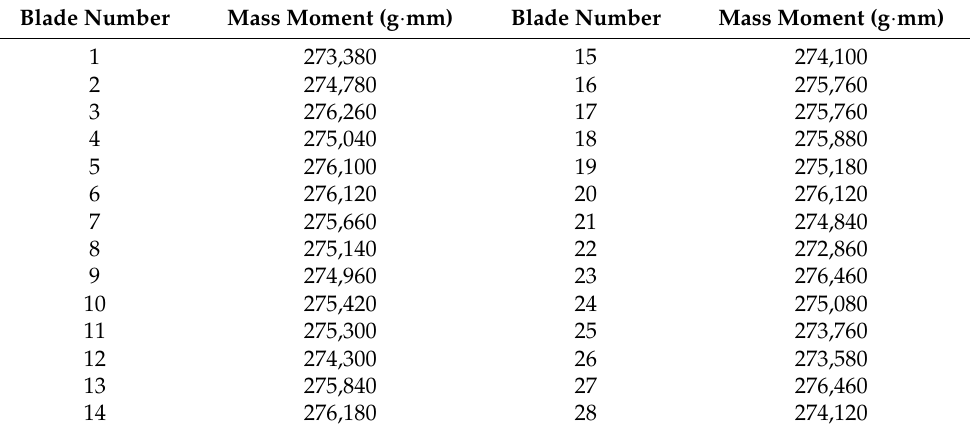
Table 2. Blade data.